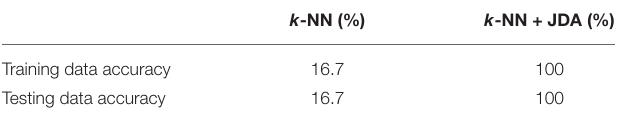
TABLE 1 | Classification results for the heterogeneous population case study with geometric and material differences, trained on the labeled source domain and applied to unlabeled target domain (Gardner et al.,